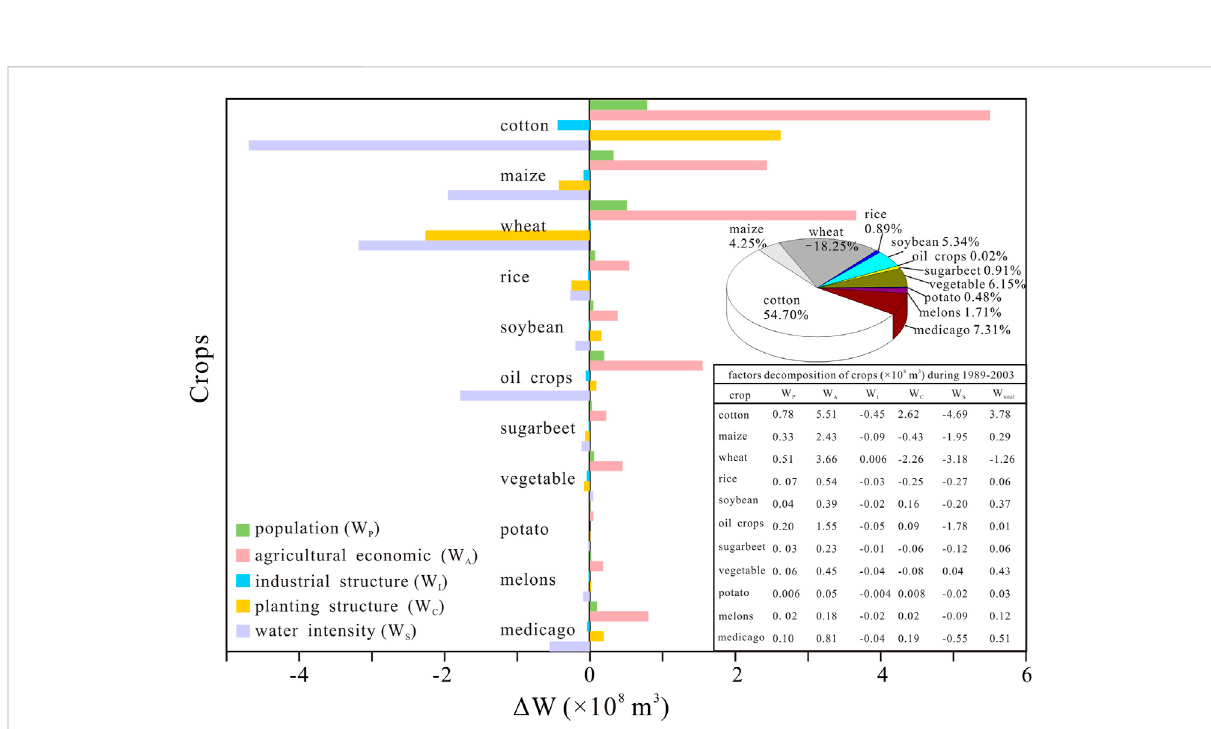
FIGURE 10 DecompositionanalysisofchangesinWFofdifferentcropsfrom1989to2003.Note:theexploredpiechartrepresentscontributionofdifferent crop WF; the table lists the results of LMDI factor decomposition for different